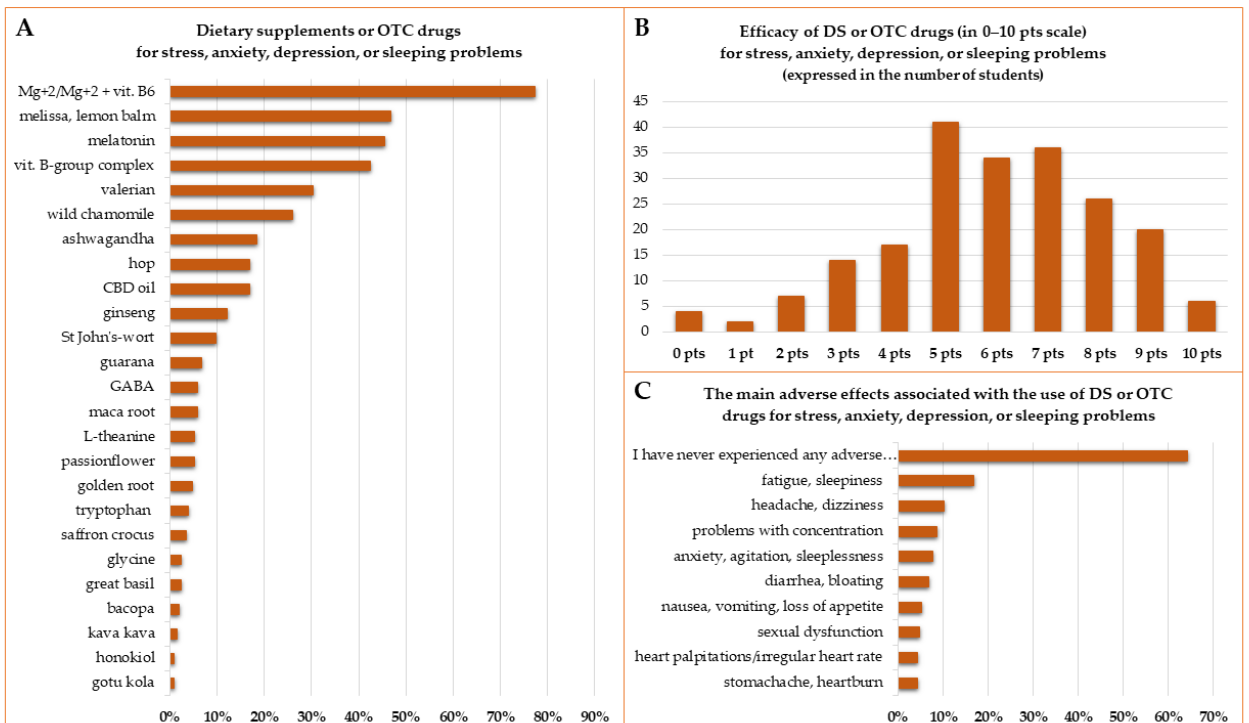
Figure 6. The most commonly chosen dietary supplements or OTC drugs for stress, anxiety, depression, or sleeping problems in the academic year 2020/2021. CBD—cannabidiol ( A ), the efficacy of DS or OTC drugs assessed by the students (0—completely ineffective, no improvement, 10—fully effective, complete disappearance of symptoms) ( B ), and the main adverse effects combined with the use of dietary supplements or OTC drugs for stress, anxiety, depression, or sleeping problems ( C ). Figure 6C presents adverse effects which were indicated by more than 4% of respondents; less commonly reported adverse effects are mentioned in the main text. The genus and species names of herbs from the Figure 6A are as follows (in the order from the most frequently used): Melissa officinalis L. (melissa, lemon balm), Valeriana officinalis L. (valerian), Matricaria recutita